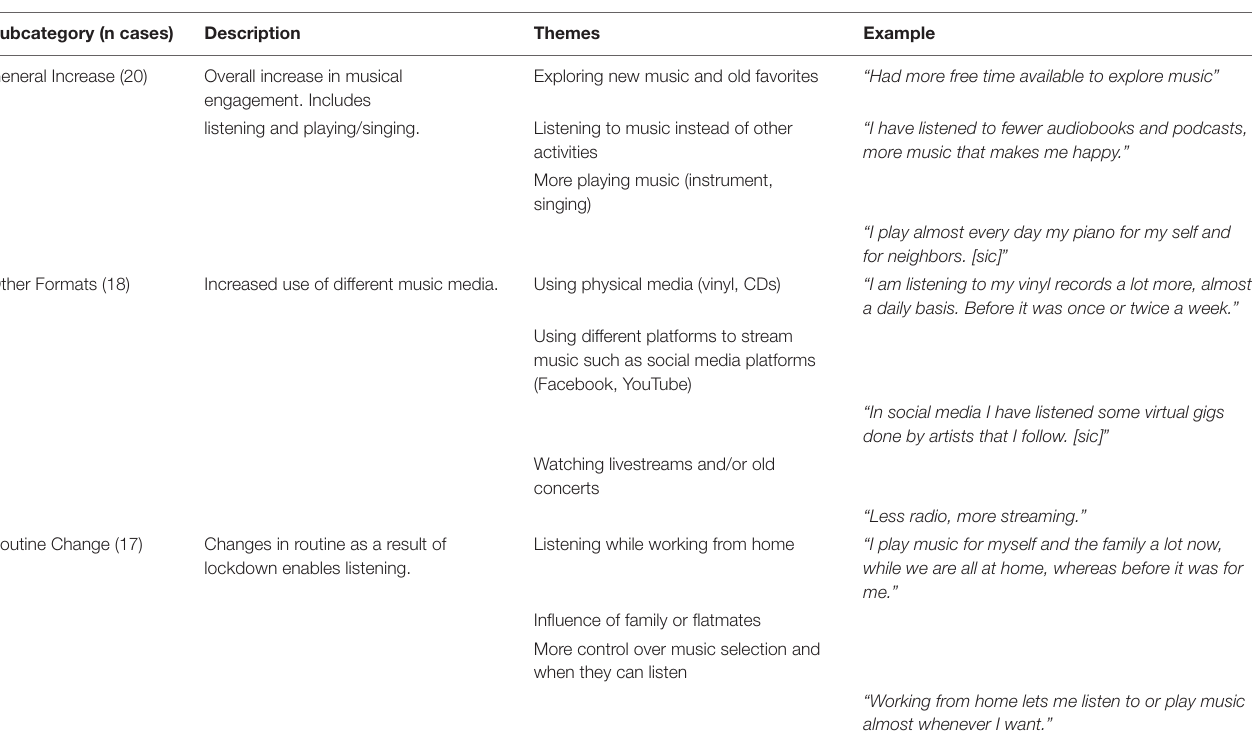
TABLE 3 | Subcategories related to More